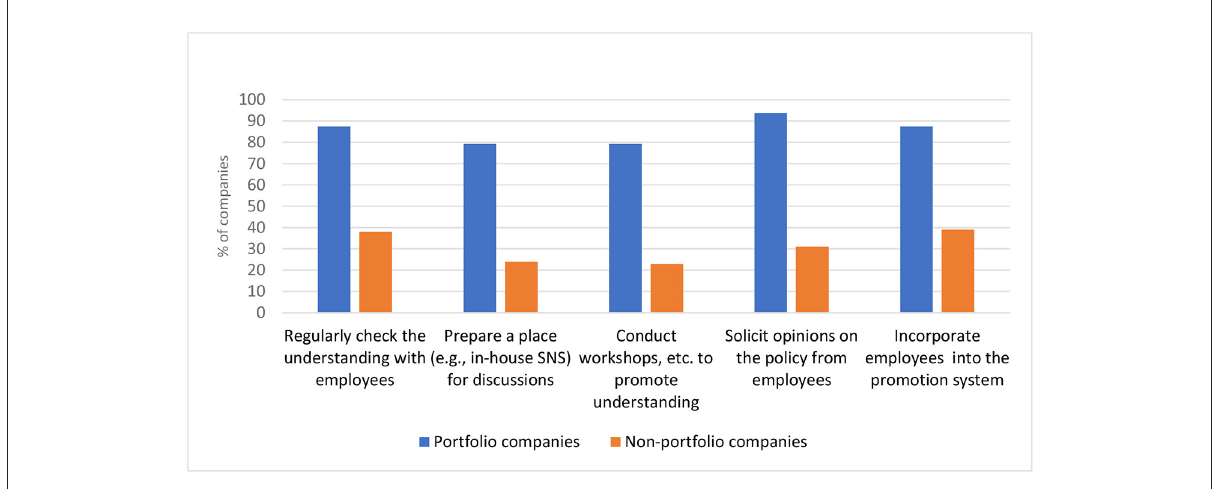
FIGURE9 Measures to promote interactive